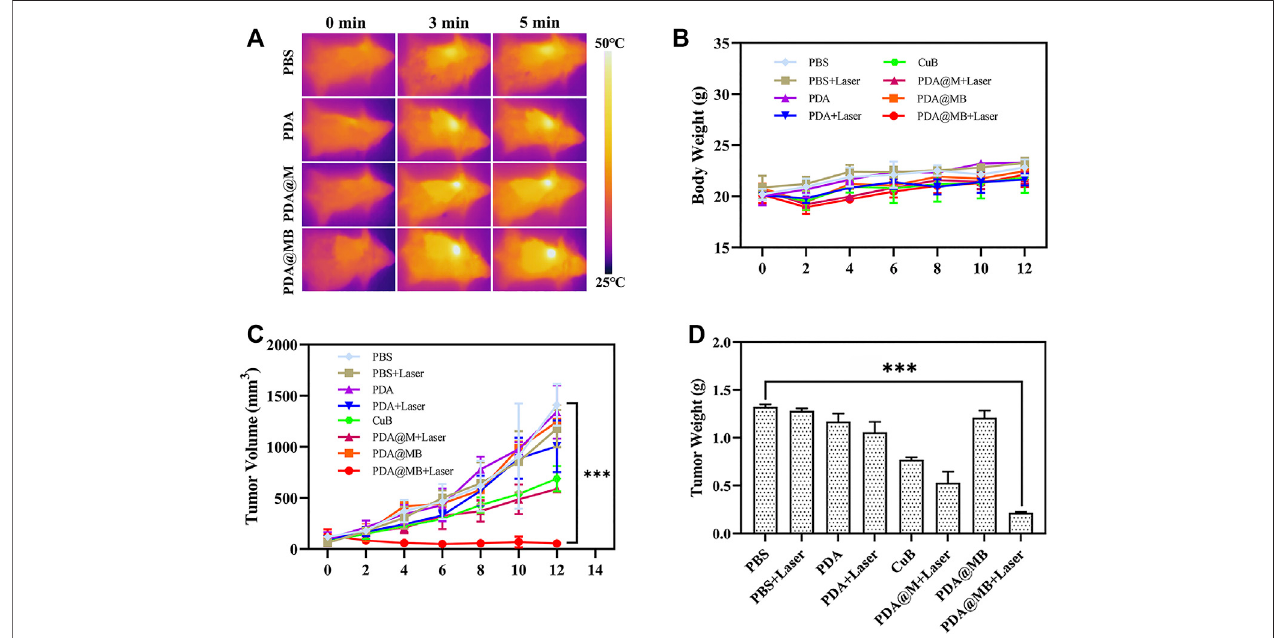
FIGURE 6 | (A) IR thermal images of tumors in BALB/c mice during NIR laser irradiation (808 nm, 2 W cm − 2 ) after injection with PBS, PDA, CuB, PDA@M, and PDA@MB. (B) Body weight curves of BALB/c mice during treatment ( n = 4). (C) Tumor volume curve of BALB/c mice during treatment. (D) Average weight of tumors collected from the BALB/c mice after treatments on the 14th day ( n = 4, mean ± SD, pp p < .01, ppp p < .001).